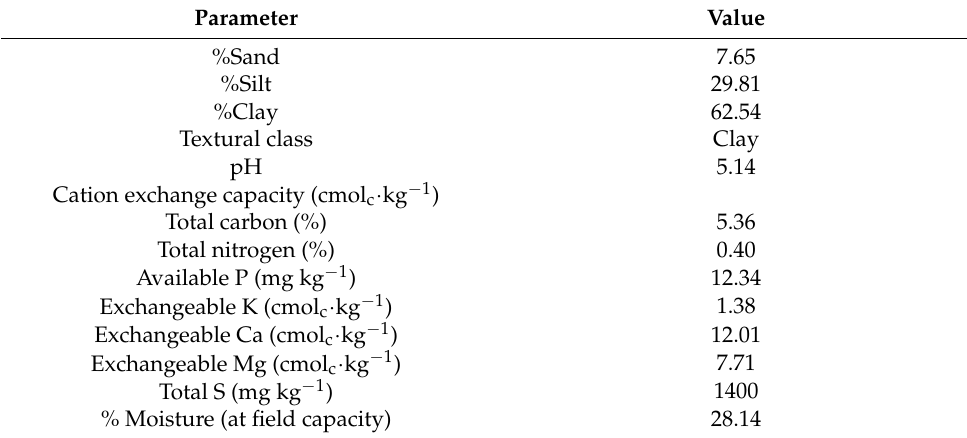
Table A1. Physicochemical properties of initial soil.